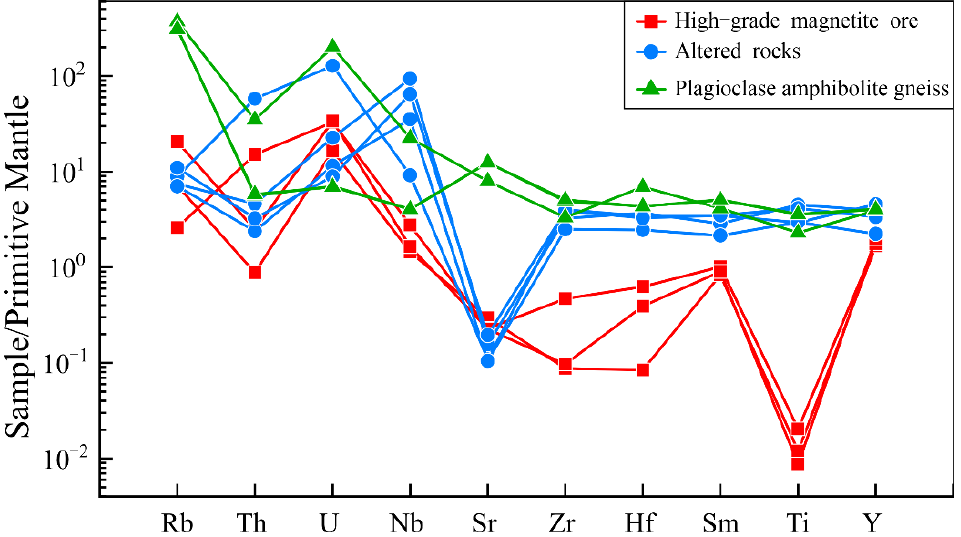
Figure 6. Primitive mantle-normalized trace elements patterns of Gongchangling No. 2 Mining Area.